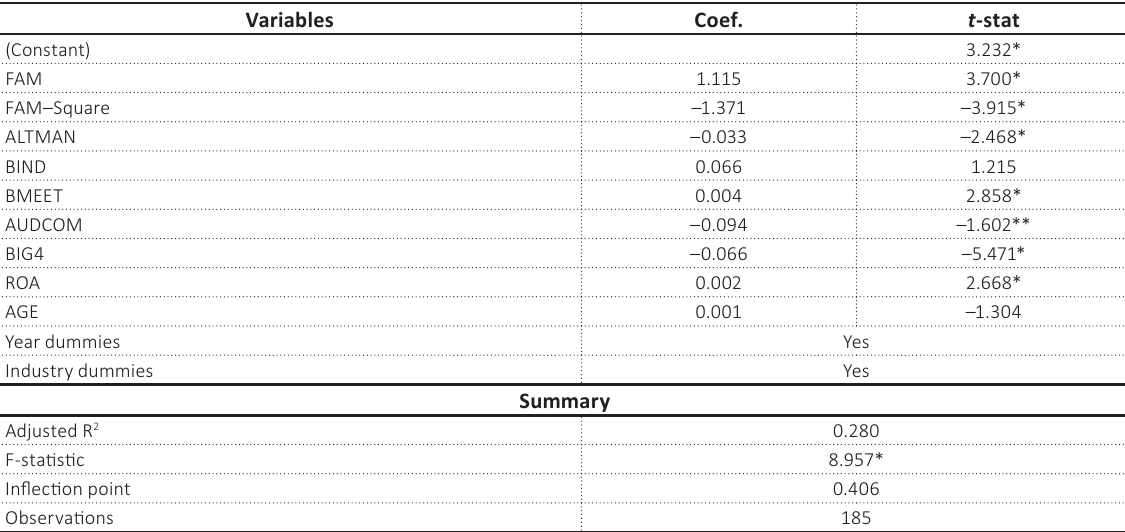
Table 7. Nonlinearities between family ownership and earnings